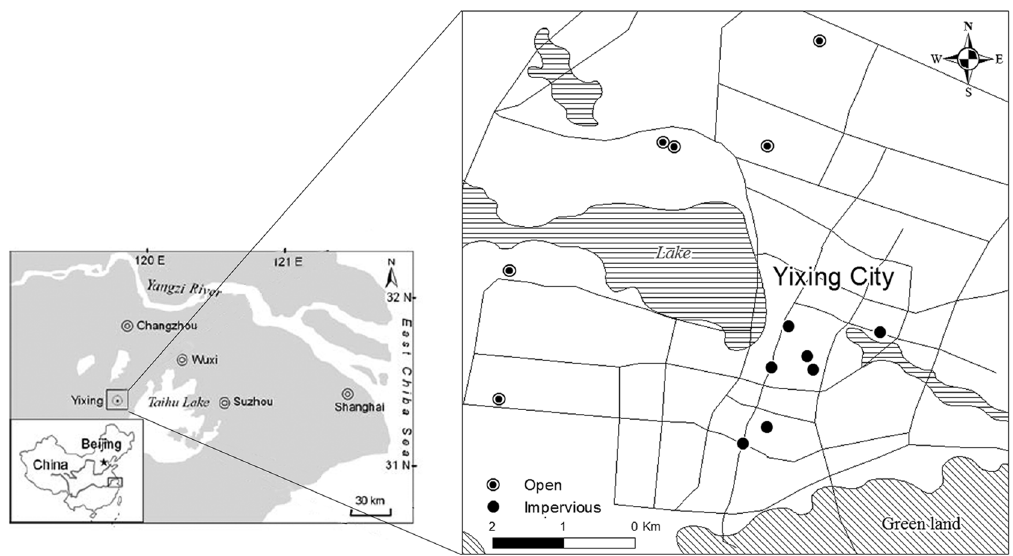
Figure 1. Soil sampling points in Yixing city. Seven sites were selected for impervious-covered soils, and six sites with similar soil parent materials were selected for open soils. Soil samples were collected at 0–20 cm depth.